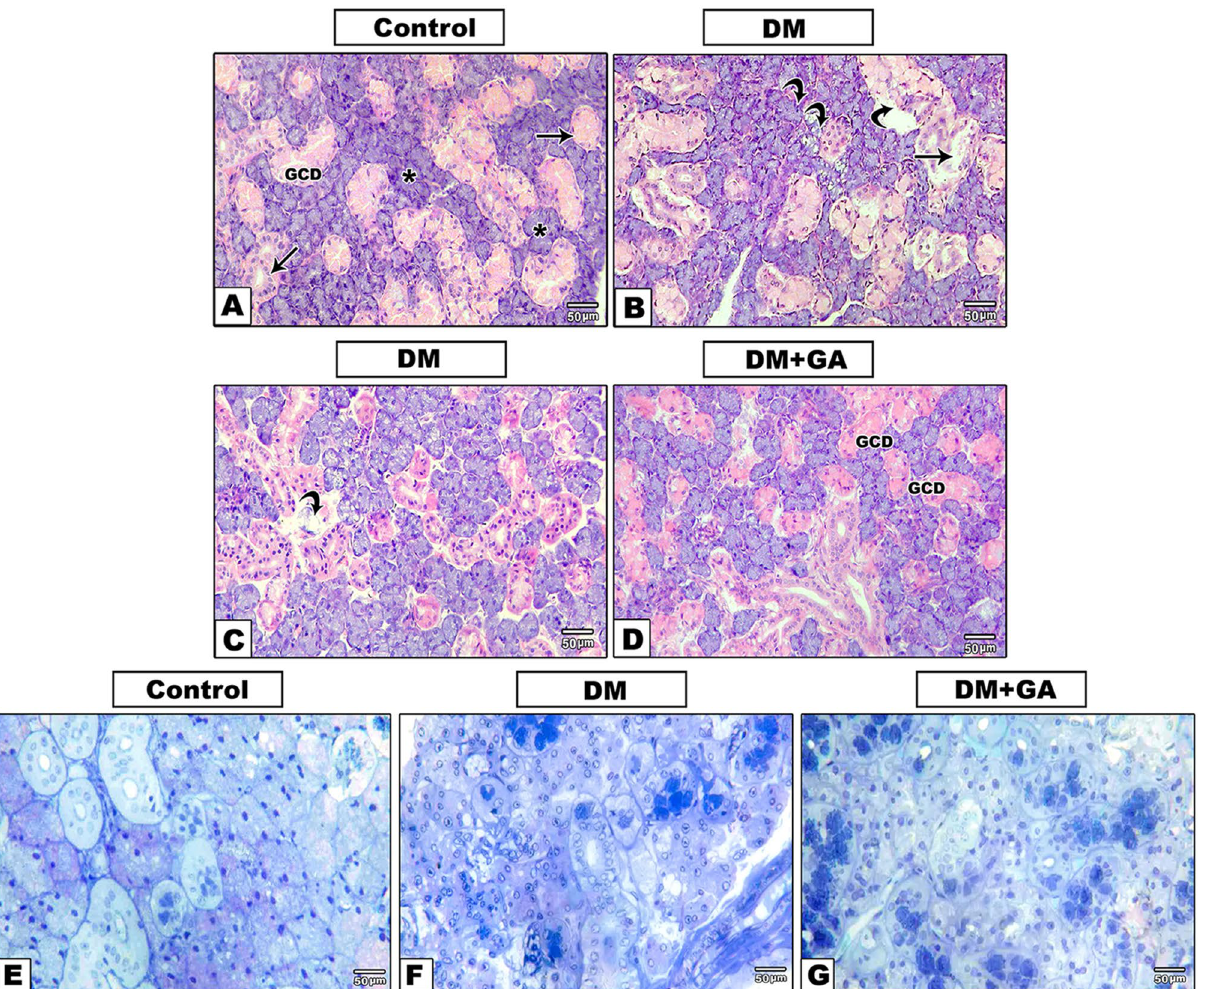
Figure 1. Haematoxylin and eosin-stained SMG showing parenchymatous structure with acini (asterisks) and interlobular ducts (arrows) with prominent granular convoluted ducts (GCD) in control group ( A ). Diabetic group showed vacuolation in both acini and GCD, with stagnation of secretions (curved arrows) ( B , C ). GA treated group ( D ) revealed an ameliorative effect by reversing the diabetes impact with minimal atrophy and vacuolations. Similarly, in semithin sections of diabetic SMG ( F ) obvious loss of secretory granules in acinar cells and disruption of acinar and ductal structures were found in addition to vacuolation and nuclear changes, the changes were reduced by GA application ( G ) that restored almost normal structure resembling control group ( E ) (H&E, × 20; Semithin sections TB stain, ×